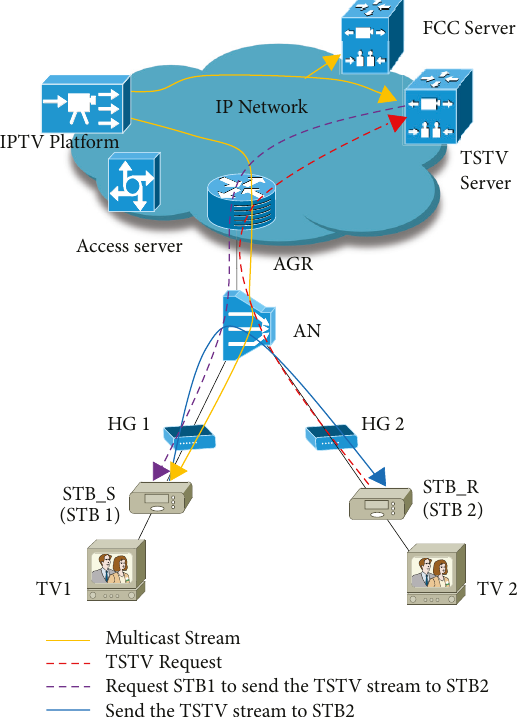
Figure 5: The new TSTV solution principle.